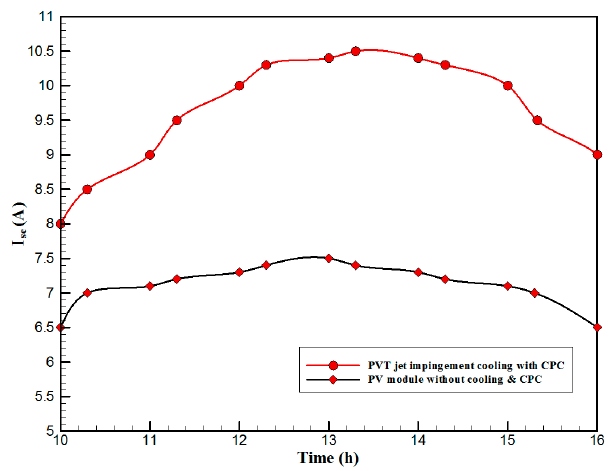
Figure 12. The hourly variation of short-circuit current for the PVT solar collector with CPC.